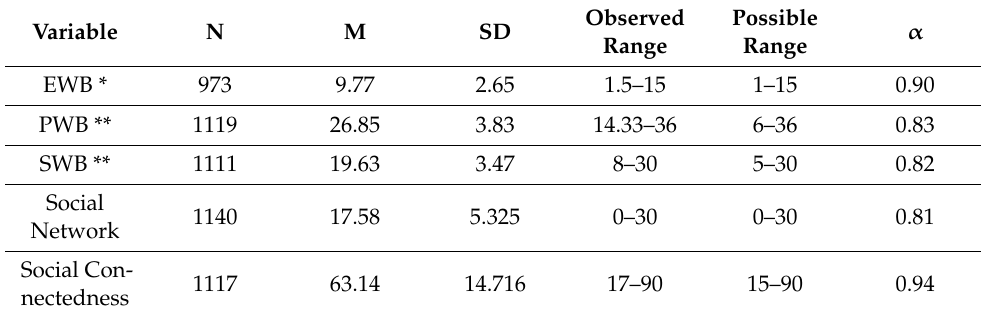
Table 1. Descriptive statistics for wellbeing and social resources